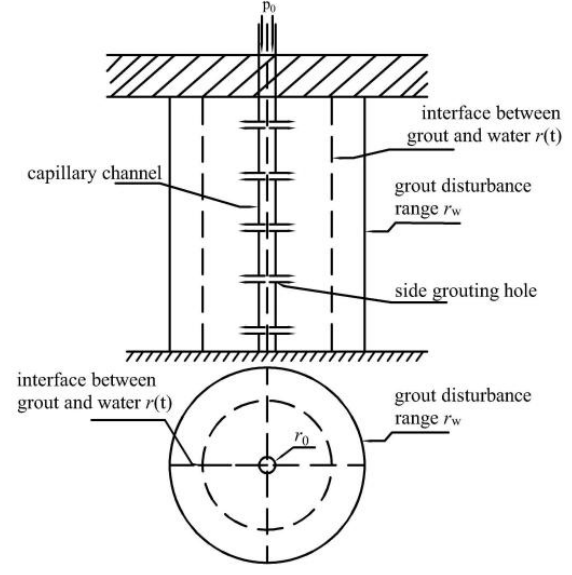
Figure 1. Schematic diagram of the column diffusion of Bingham fluid.